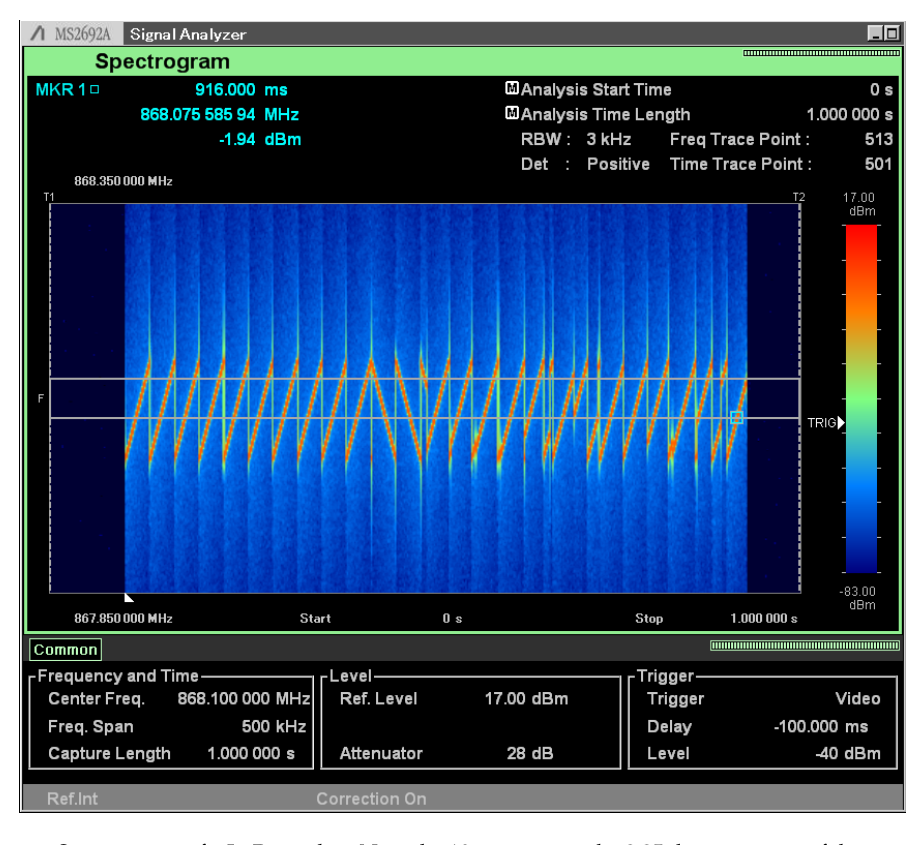
Figure 6. Spectrogram of a LoRa packet. Note the 10 up sweeps, the 2.25 down sweeps of the preamble, and the discontinuities that represent the